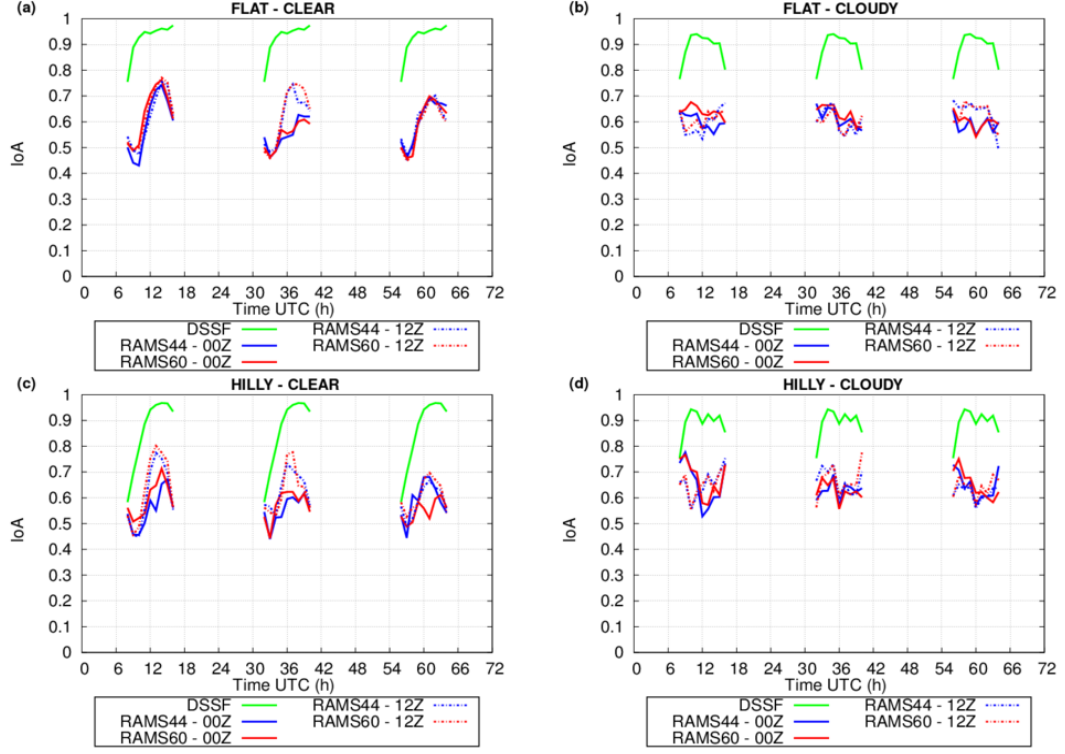
Figure 11. Same as Figure 7, but for the IoA statistical score: flat-clear ( a ); flat-cloudy ( b ); hilly-clear ( c ) and hilly-cloudy ( d ).